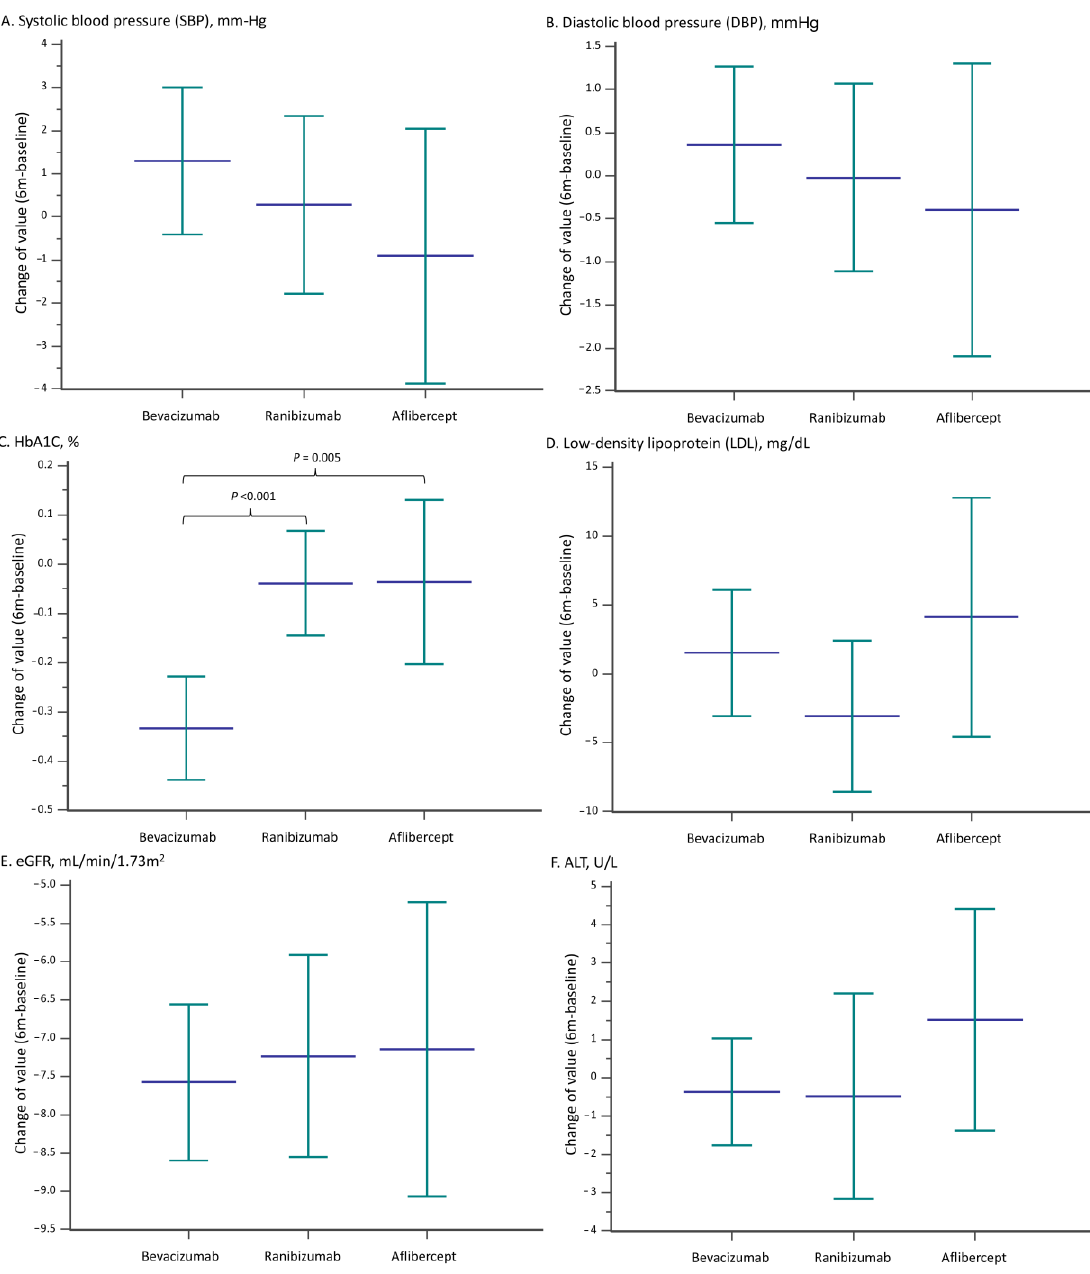
Figure 3. Changes from baseline to six months of ( A ) systolic blood pressure, ( B ) diastolic blood pressure, ( C ) HbA1C, ( D ) low-density lipoprotein, ( E ) eGFR, and ( F ) ALT for patients receiving dif- ferent anti-vascular endothelial growth factor agents in the IPTW-adjusted cohort. ATL—alanine aminotransferase; eGFR—estimated Glomerular filtration rate; HbA1C—glycated hemoglobin; IPTW— inverse probability of treatment weighting.